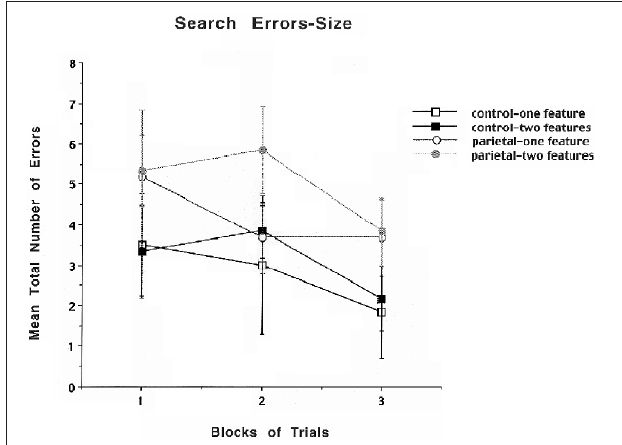
FIGURE 4 | Mean number of search errors for one or two features for object size for control and parietal cortex lesioned rats as a function of blocks of trials. Each block consisted of 20